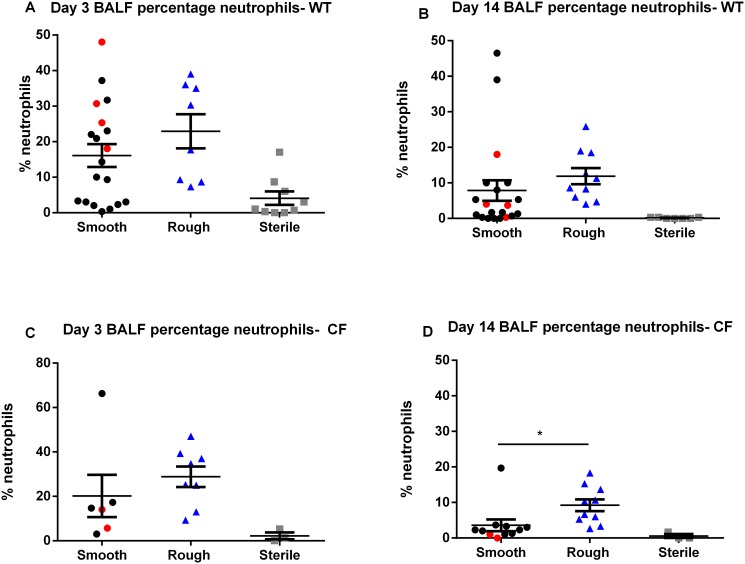
BALF neutrophil percentage.(A, B, C and D) Inoculation with rough morphotype causes greater BALF neutrophil percentage than smooth morphotype at 14 days post-inoculation in CF mice (D). Red circles indicate smooth morphotype inoculation with conversion to rough morphotype. Minimal BALF neutrophilia was seen after sterile thrombin/fibrinogen inoculation. (N = 9–20 mice in each M. abscessus group, N = 3–8 mice in each sterile group). * p< 0.05. Data displayed as mean ± SEM of group, pooled from 2–3 replicate experiments for each morphotype.